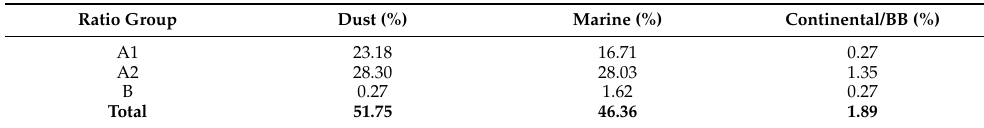
Table 5. Rate in percentage of marine, dust, and continental/BB aerosols related to AE (440–870 nm) versus AOD (440 nm) for PR station from 2000 to 2020 (N =